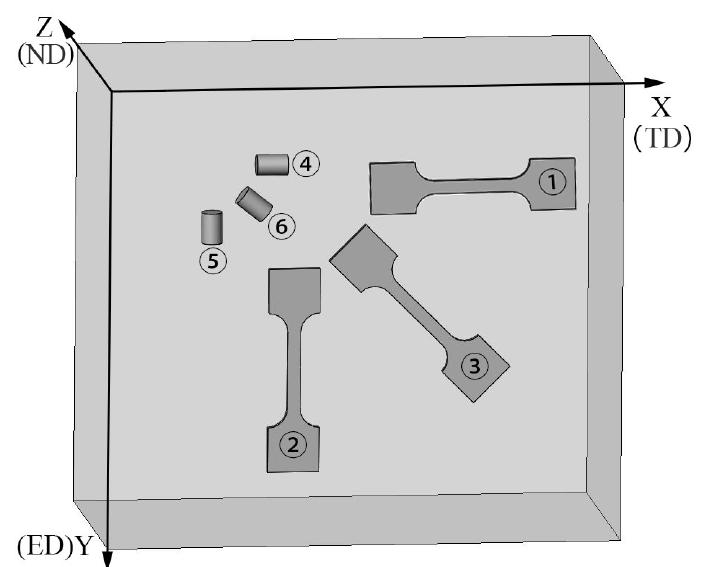
Figure 3. Schematic diagram of experimental samples.